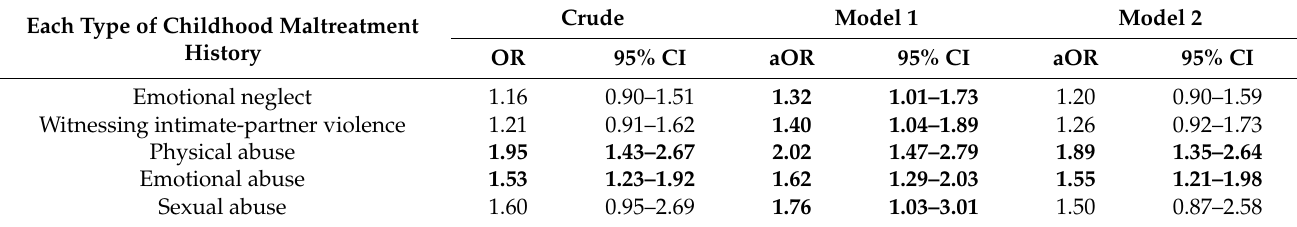
Table 4. Bivariate and multivariate associations between each type of childhood maltreatment history and premenstrual